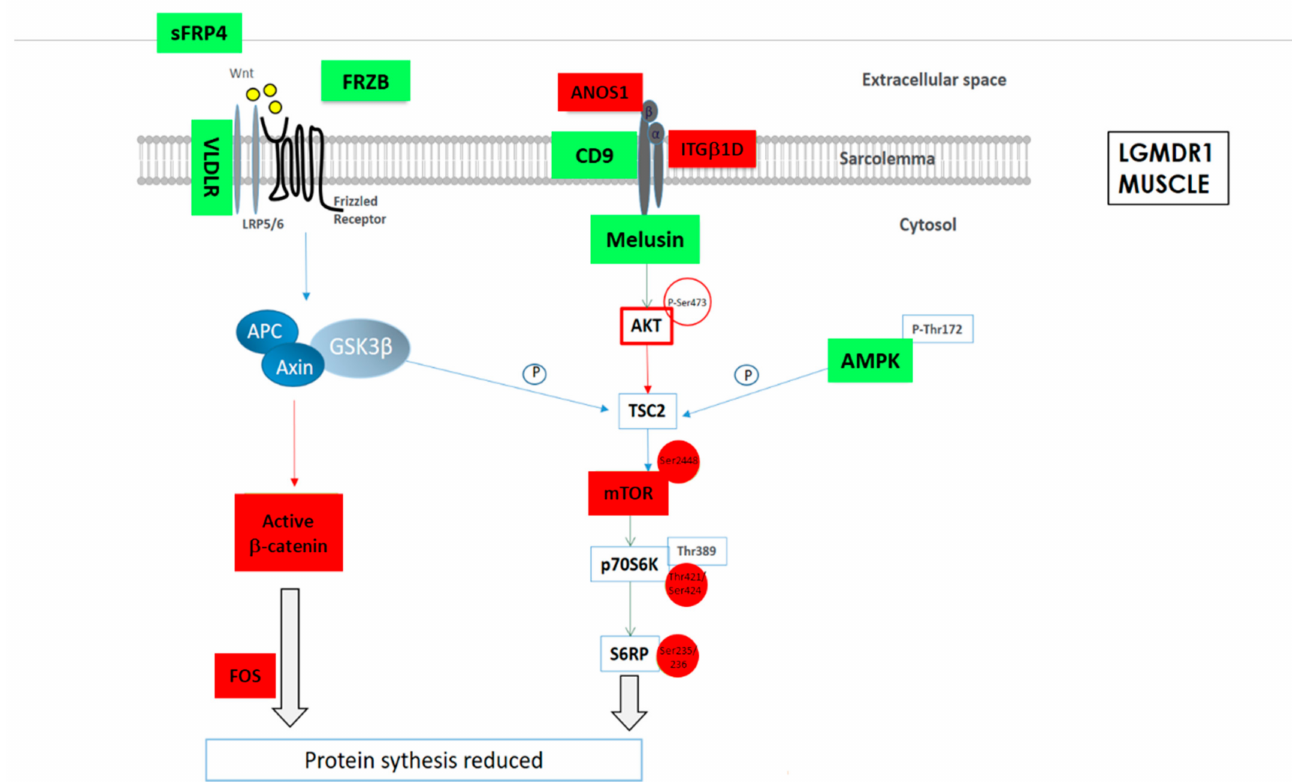
Figure 3. Schematic representation of the altered protein expression or phosphorylations in Wnt and mTOR signaling pathways in LGMDR1 muscle. Green: Upregulated expression or phosphorylation in LGMDR1. Red: Downregulated expression in